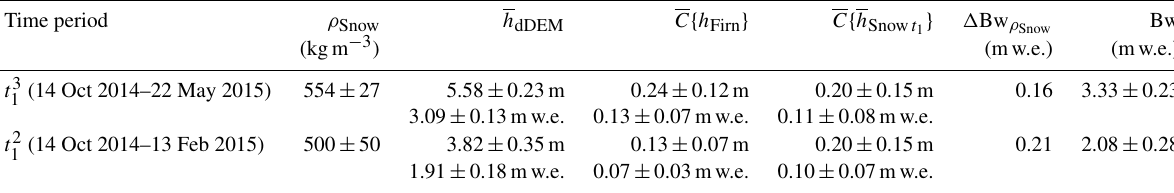
Table 3. Glacier-wide geodetic winter mass balance and associated error, calculated from Eq. (1). The elevation difference, h dDEM , is observed from remote sensing data, while the bulk snow density ( ρ Snow ) and densification of firn ( C { h Firn } ) and fresh snow ( C { h Snow t are inferred values from field measurements. For each variable its value and the associated error are shown, and in the row below its conversion into mass balance is shown. (cid:49) Bw ρ shows the contribution of the bulk snow density into the uncertainty in the mass balance. Snow The total uncertainty of Bw is computed as the quadratic sum of the uncertainty (in mw.e.) of the elevation difference, firn and fresh snow densification, and bulk snow